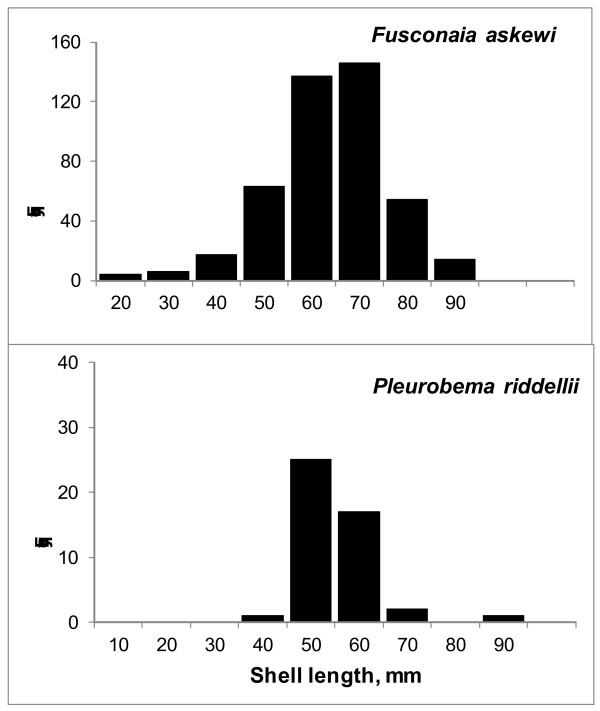
Size-frequency distribution of liveFusconaia askewi,andPleurobema riddelliishell length.